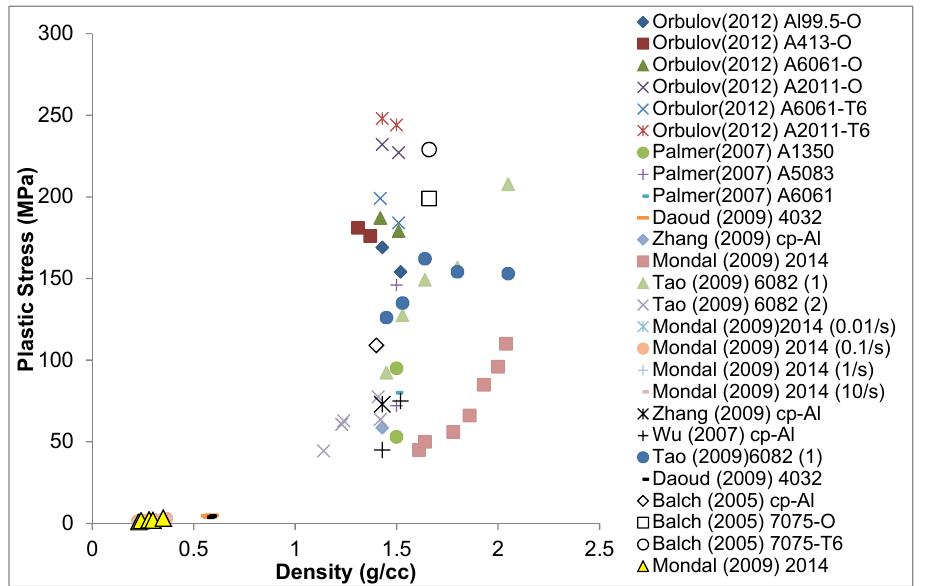
Figure 9. Plastic strength of aluminum matrix syntactic foams plotted against density. In the legend the nomenclature refers to the last name of the first author (year) alloy type-heat treatment (strain rate, if used as a